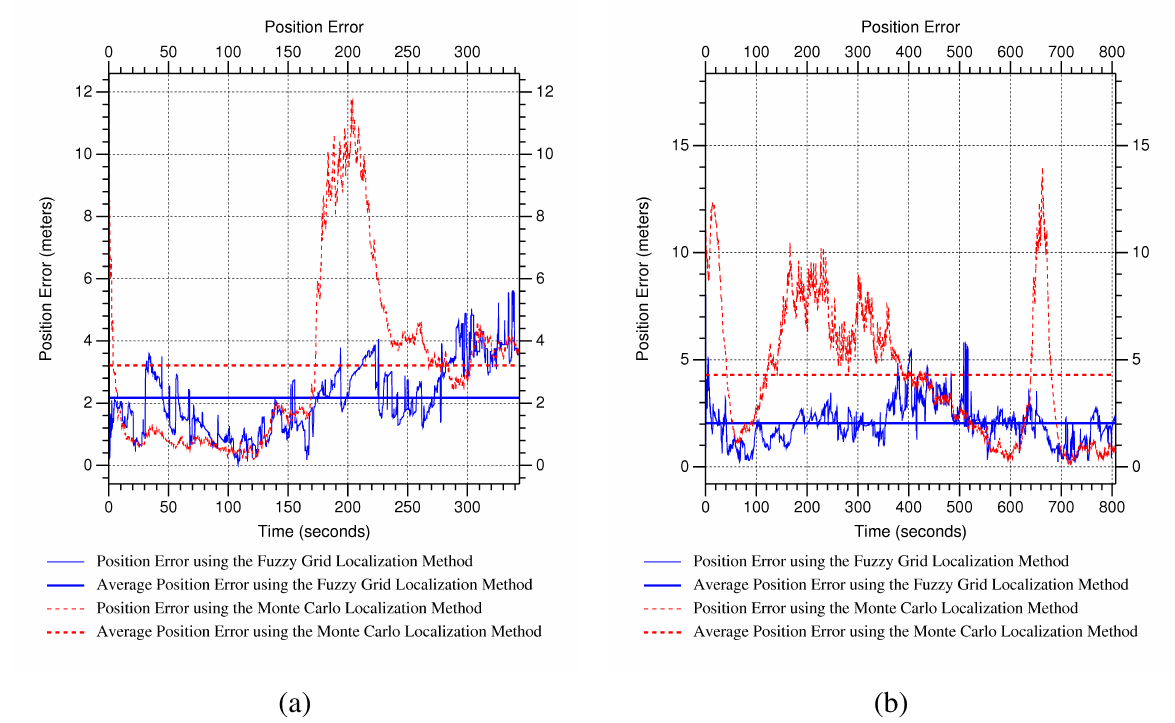
Figure 9. Position error in tracking experiment: (a) the robot crossing an intersection with a long corridor and (b) the robot navigating through a long